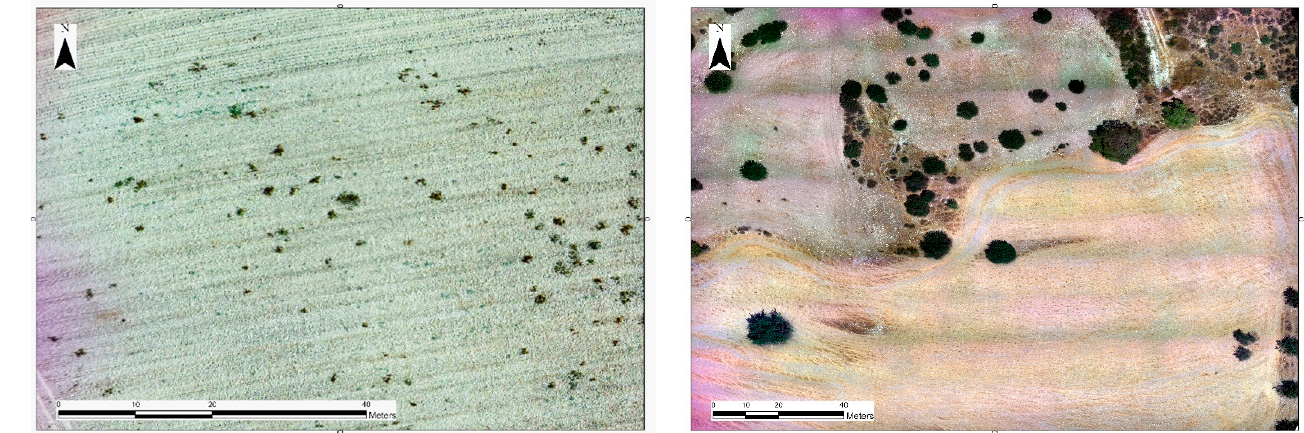
Figure 4. Mosaics used in this study: Area 20 ( left ) and Area 6 ( right ).